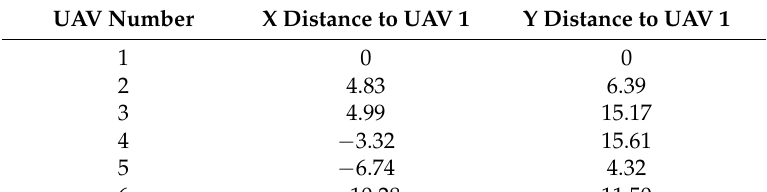
Figure 7. Formation optimization results of minimum formation vertical distance. Table 3. Optimization results of indicator 3.